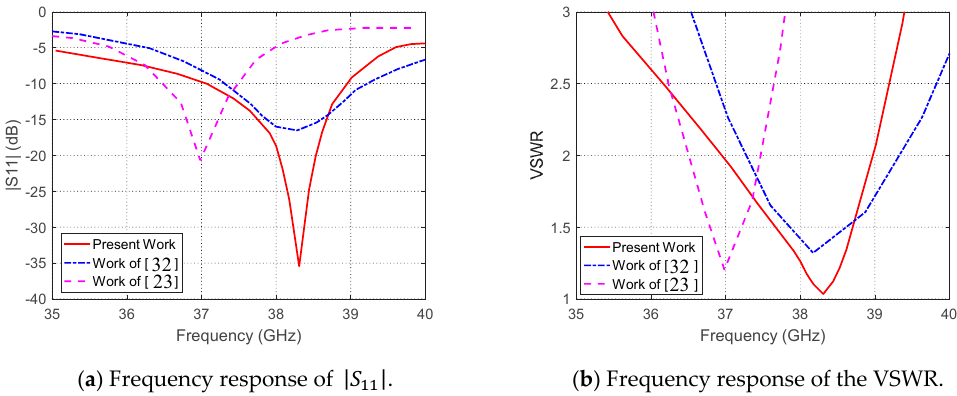
( b ) Frequency response of the VSWR. Figure 19. Comparisons between the frequency responses of the | S 11 | and VSWR obtained in the present work for the proposed dual-band antenna and those obtained in [23] and [32] at 38 GHz.